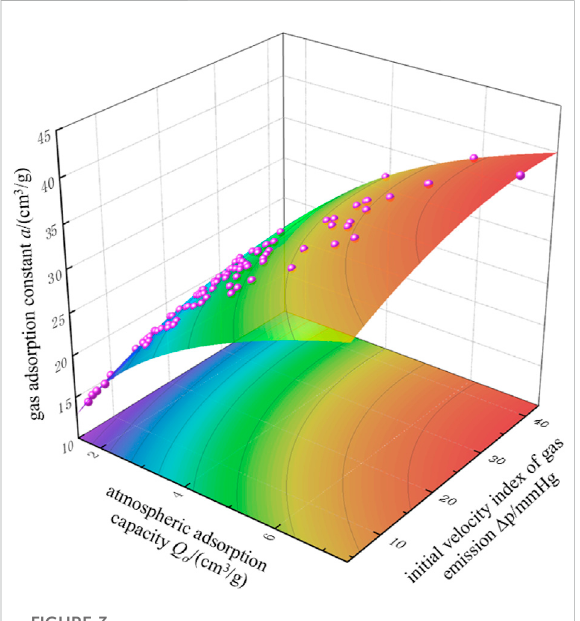
FIGURE 3 Surface fi tting plot with gas adsorption constant a and Q 0 - Δ p